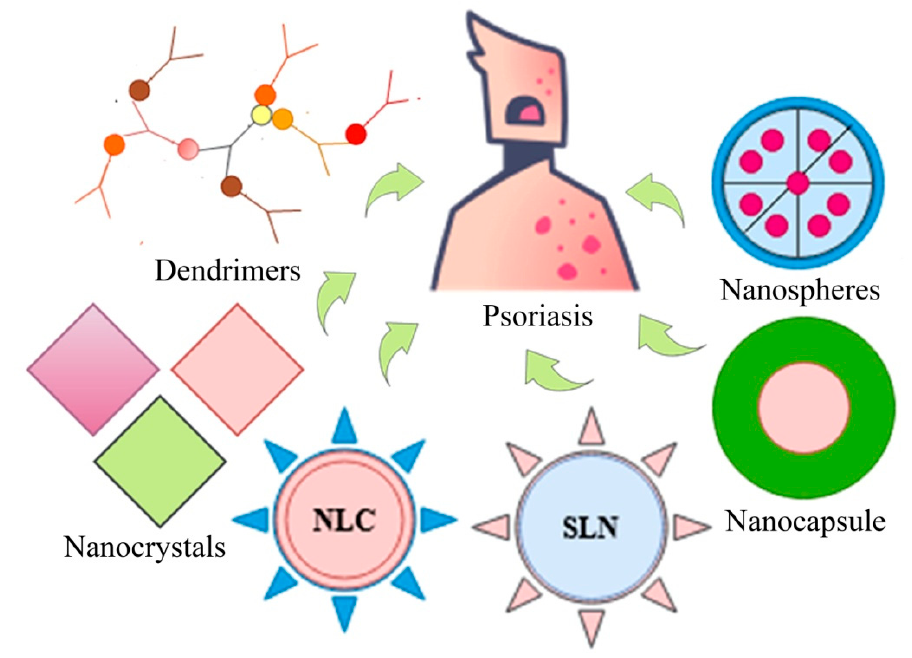
Figure 5. Basic structures of particulate drug delivery systems. Table 7. Recent studies in particulate drug delivery systems for psoriasis treatment.